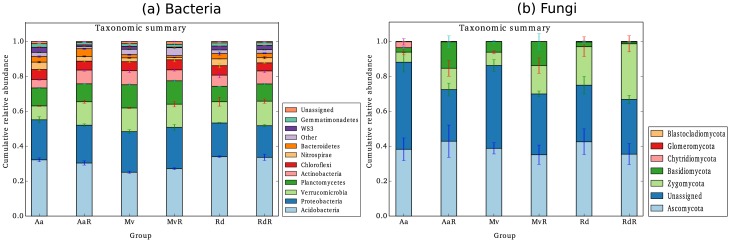
Taxonomic summary of the relative abundance of (a) bacterial and (b) fungal phyla in the invaded and non-invaded sites.The taxa are arranged as per total relative abundance across all samples, with the most abundant phyla at the bottom and the least abundant phyla at the top of the y-axis. Similarly, the phylum names in the legend are arranged from the least abundant at the top to the most abundant at the bottom.